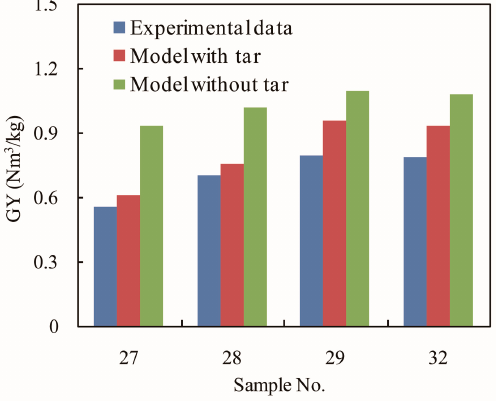
Figure 5. Comparison between experimental data and predicted data based on different models for GY.